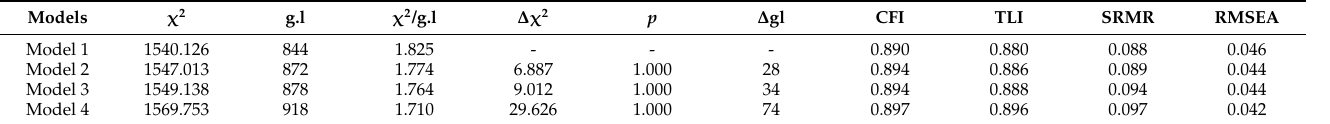
Table 4. Multigroup analysis of invariance by gender.